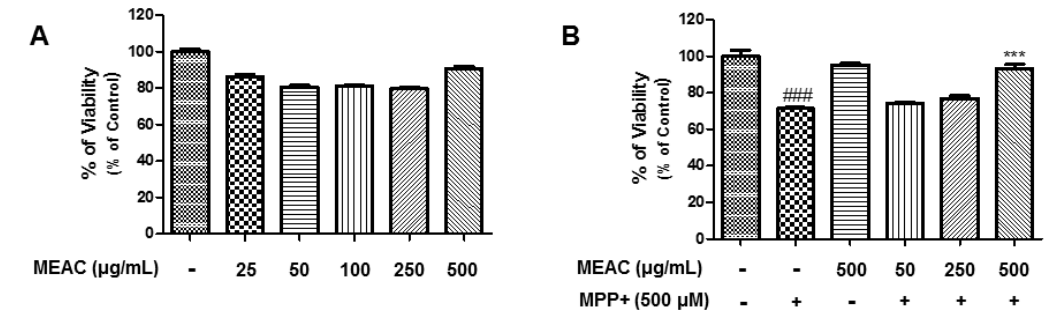
Figure 5. MEAC treatment on viability of N27-A cells. ( A ) Action of di ff erent doses of MEAC treatments on the viability of N27-A cells. ( B ) Action of MEAC treatment against 1-methyl-4-phenylpyridinium (MPP + )-induced death in N27-A cells. Data are presented as the mean ± SEM. ### p < 0.001 versus control group; *** p < 0.001 versus MPP + -induced group ( n = 3 ).